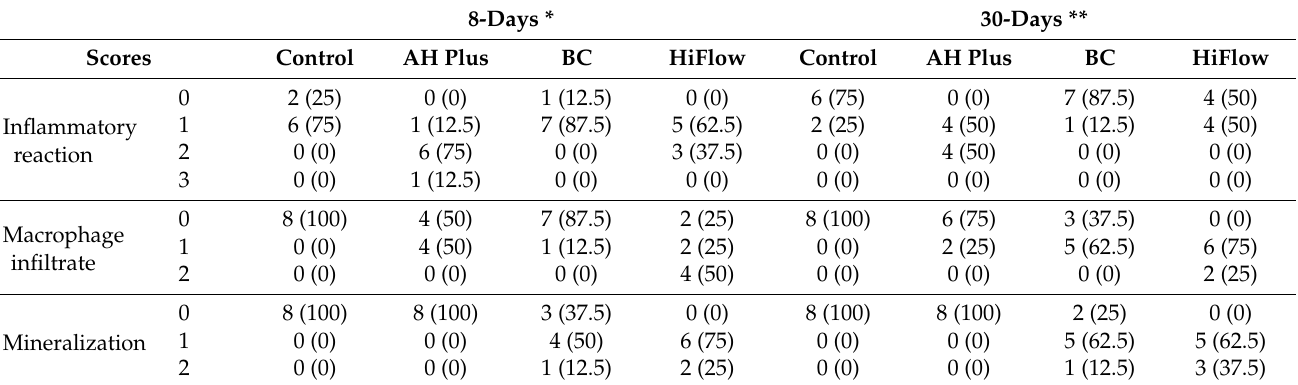
Table 3. Absolute and relative frequencies for histologic evaluation of the samples according to groups and study periods (* n = 8; ** n =